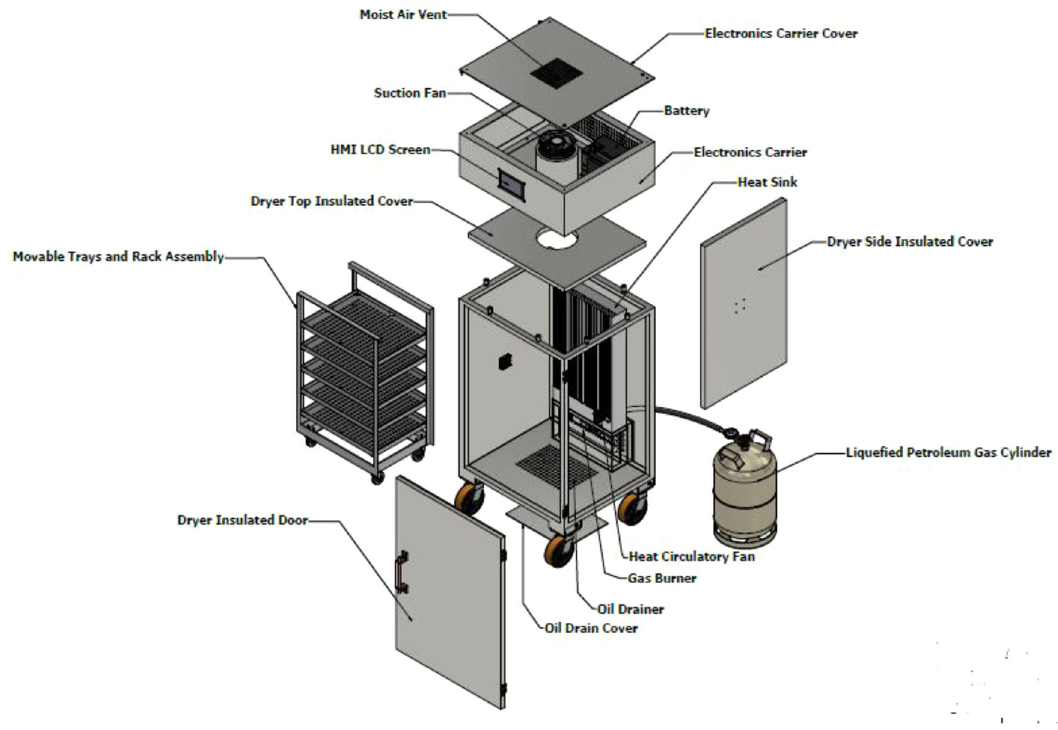
Figure 3. The main assembly of the dehydrator as exploded view including the movable tray, heat exchanger, electronic carrier, and other